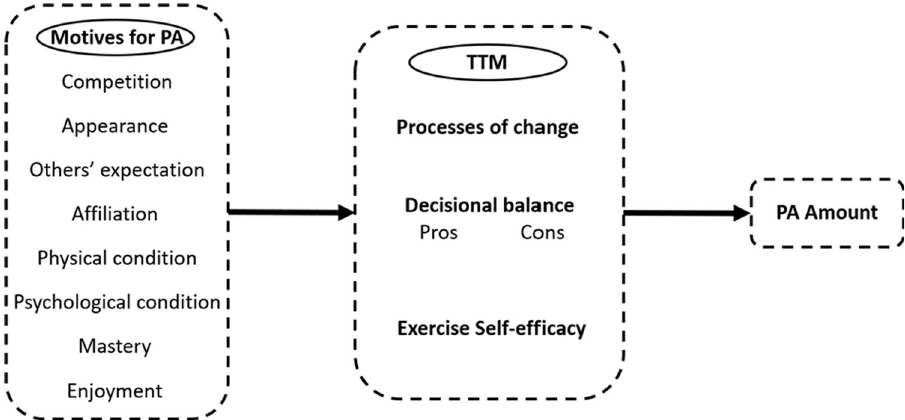
Fig 1. Hypothesized proposed relationships of TTM, motives for PA, and amount of PA.